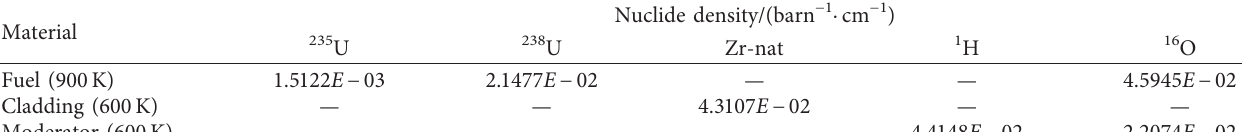
Figure 5: The simple UO 2 fuel pin cell. Table 1: The materials and the nuclide densities of the UO 2 pin cell.